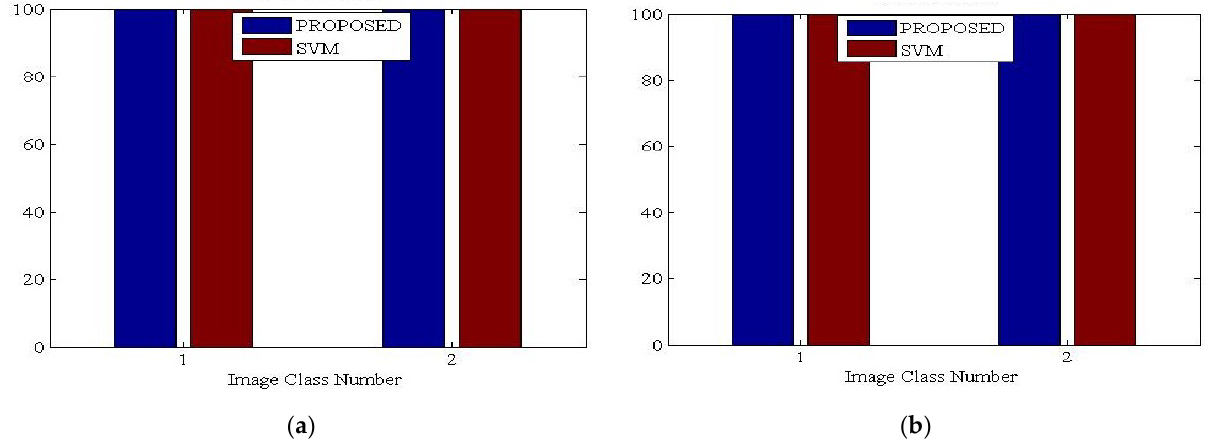
Figure 11. GAR analysis for: ( a ) Indian Pines and ( b ) Pavia University.